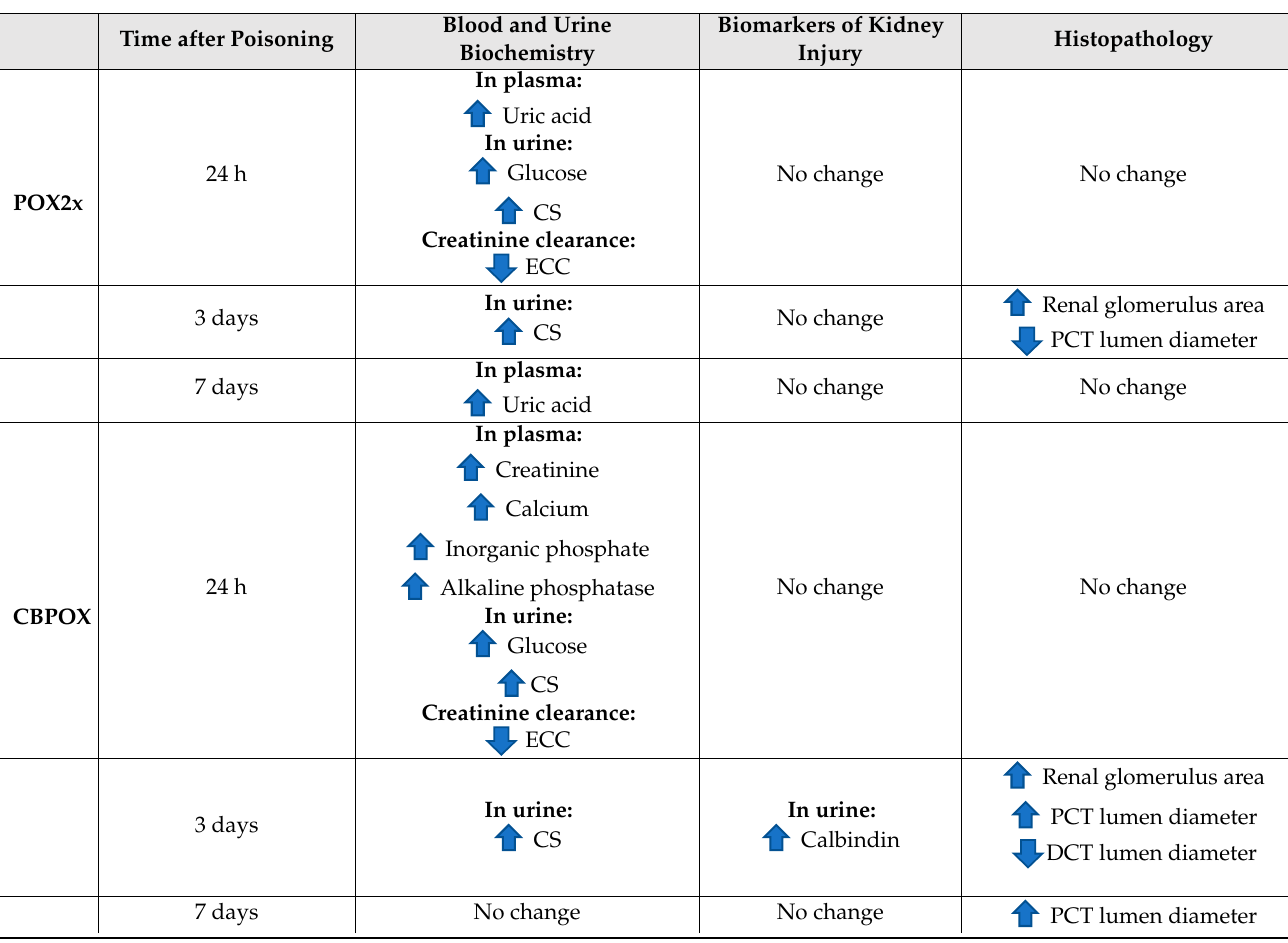
Table 2. Signs of POX nephrotoxicity in the M1 and M2 model